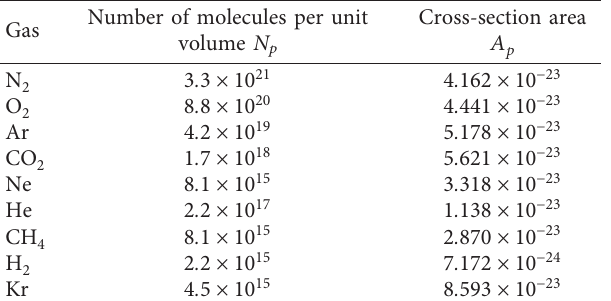
Table 5: Mie scattering values for 850nm and 1064nm.